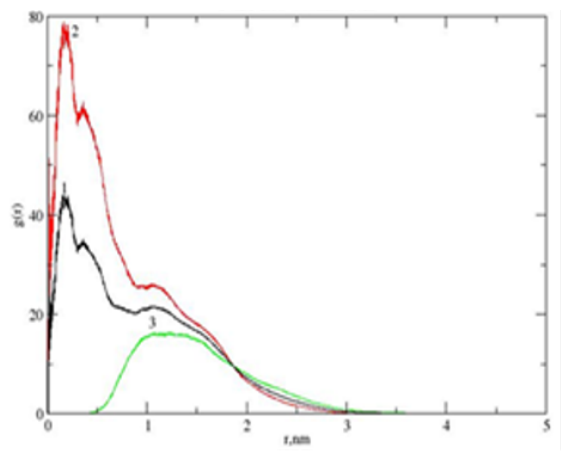
Fig. 4. Radial distribution p(r) for: dendrigraft DG2 and 16 molecules of KED peptide. Distribution curves for: peptide atoms (1); dendrigraft atoms (2); all atoms of complex (3).